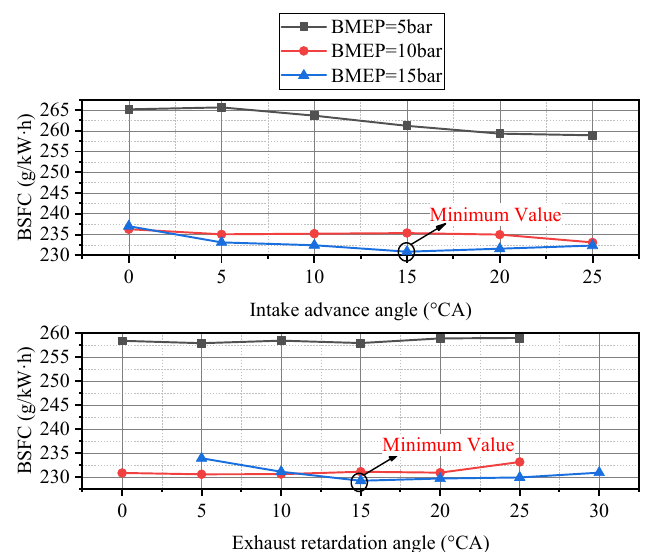
Figure 12. BSFC (Brake Specific Fuel Consumption) versus intake advance angle under baseline EVC, and BSFC versus exhaust retardation angle under the Miller cycle at different points of the operation during the test.